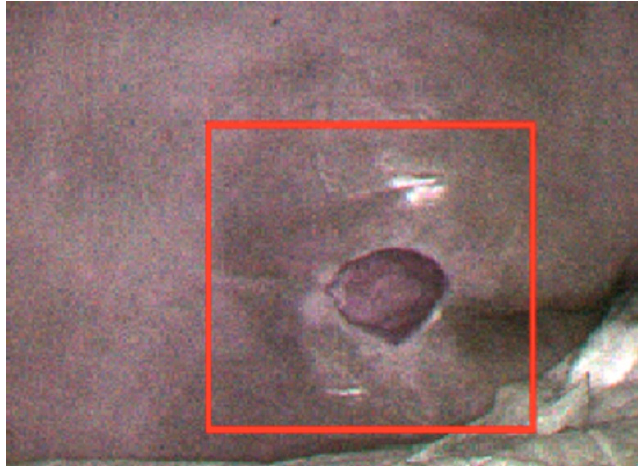
Figure 2. Hyperspectral image of coccyx sacrum pressure injury.